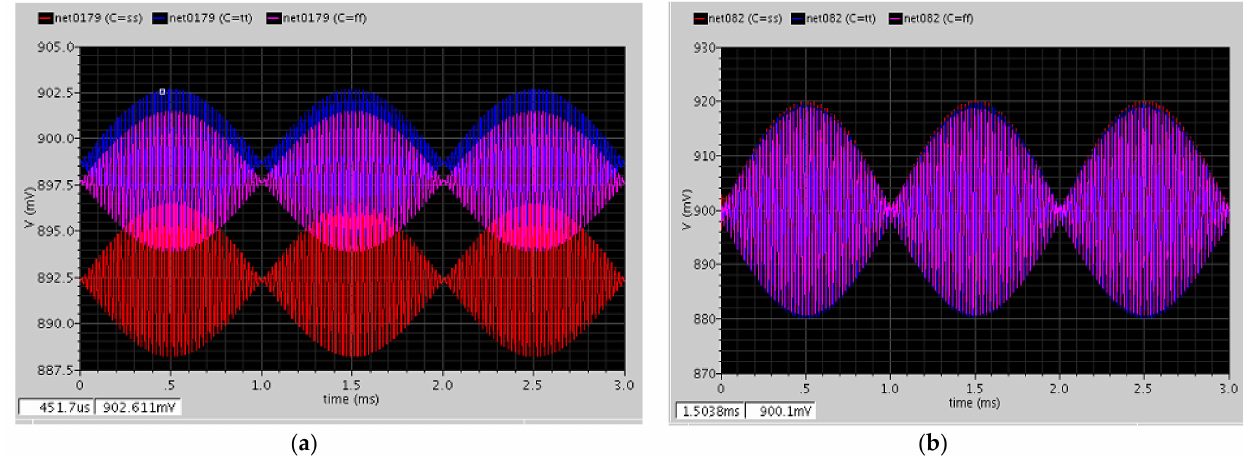
Figure 18. ( a ) After the GM-C filter circuit; ( b ) after the main amplifier circuit. After the CDS demodulation, the signal returned to the baseband, which was approxi- mately 500 Hz (Figure 19a). Then, the buffer provided enough current to push the capacitor, which was at the nanofarad level, and the gain was one (Figure 19b).